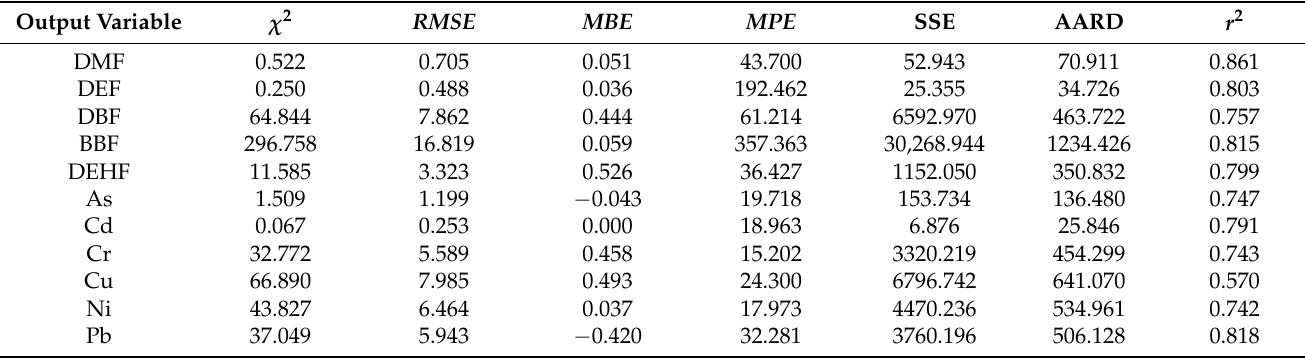
Table 2. The goodness-of-fit tests for the developed ANN